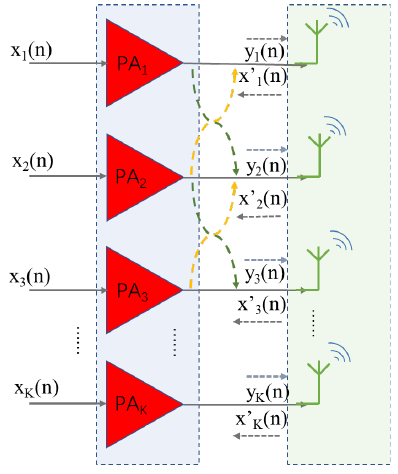
Figure 2. A k × k MIMO transmitter.